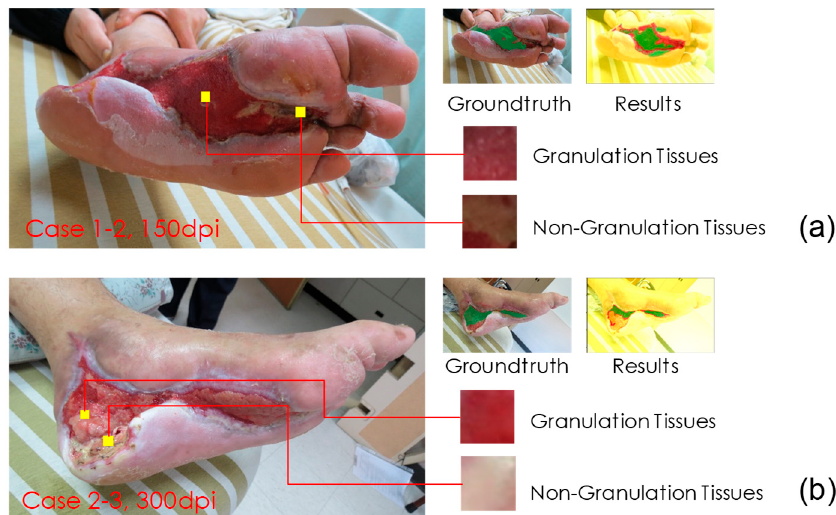
Figure 6. Comparison of cases 1-2 and 2-3 images. ( a ) Both granulation tissue and non-granulation tissue are clearly textured with image resolution at 150 dpi. ( b ) The texture of both is relatively flat and approximates the appearance of class 3, as the image resolution of this case is 300 dpi.